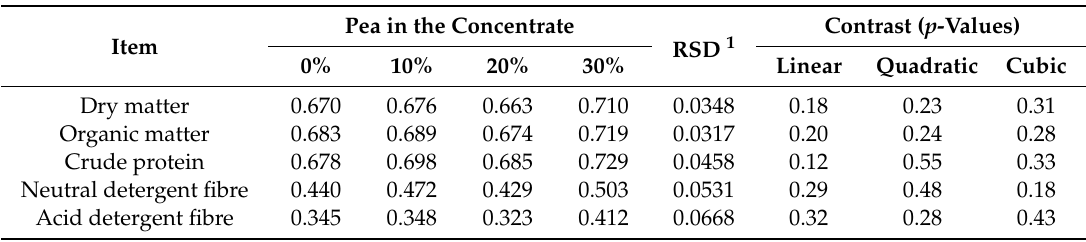
Table 2. E ff ect of the inclusion of field pea in the concentrate on total tract apparent digestibility of the diets (in vivo digestibility trial).